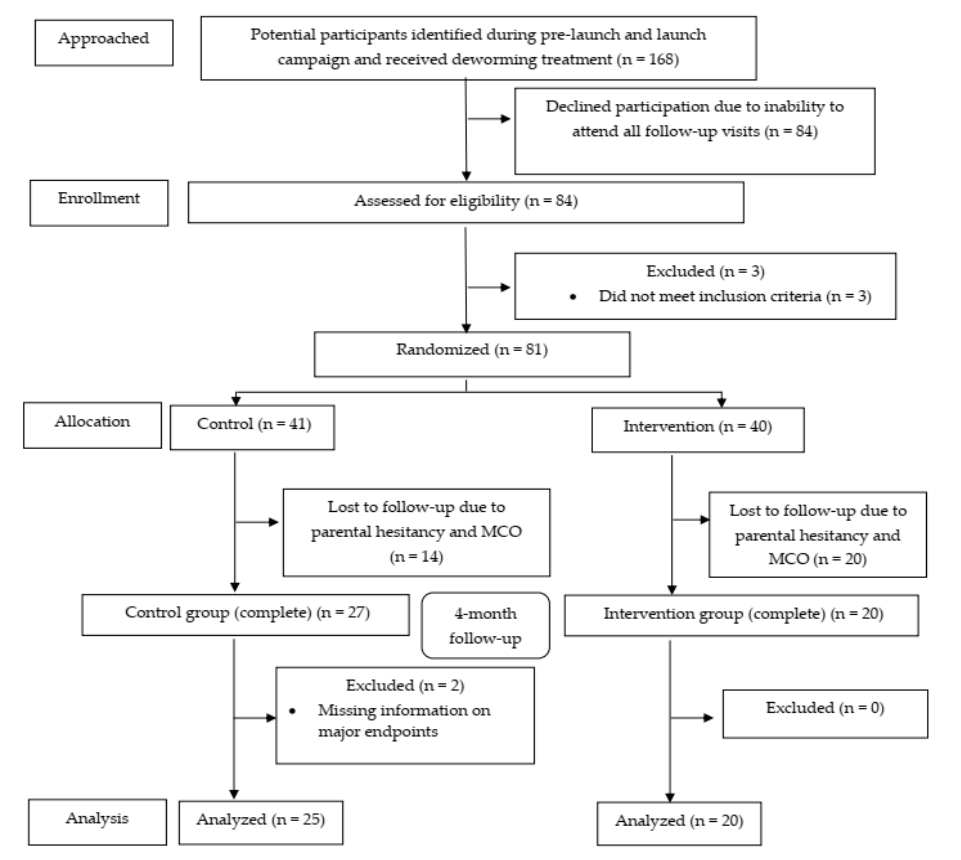
Figure 3. The CONSORT flow diagram of the study. Table 2. Comparisons of baseline parameters between control and micronutrient groups ( n =